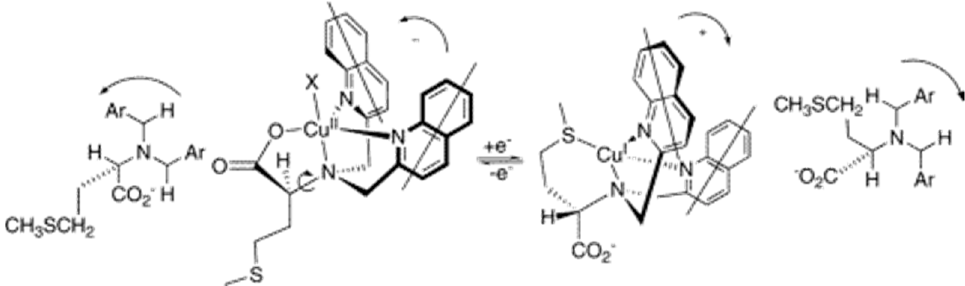
Figure 21. Redox-induced inversion of helicity in copper complexes of L -MethBQA. As a result of the presence of gearing among the three arms of the tripod near the sterically crowded tertiary amine of the ligand, a pivot about a C-N bond results in the inversion of the propeller, giving give opposite exciton-coupled circular dichroism (ECCD) spectra. Reprinted with permission from Reference [90]. Copyright (2006) American Chemical Society.